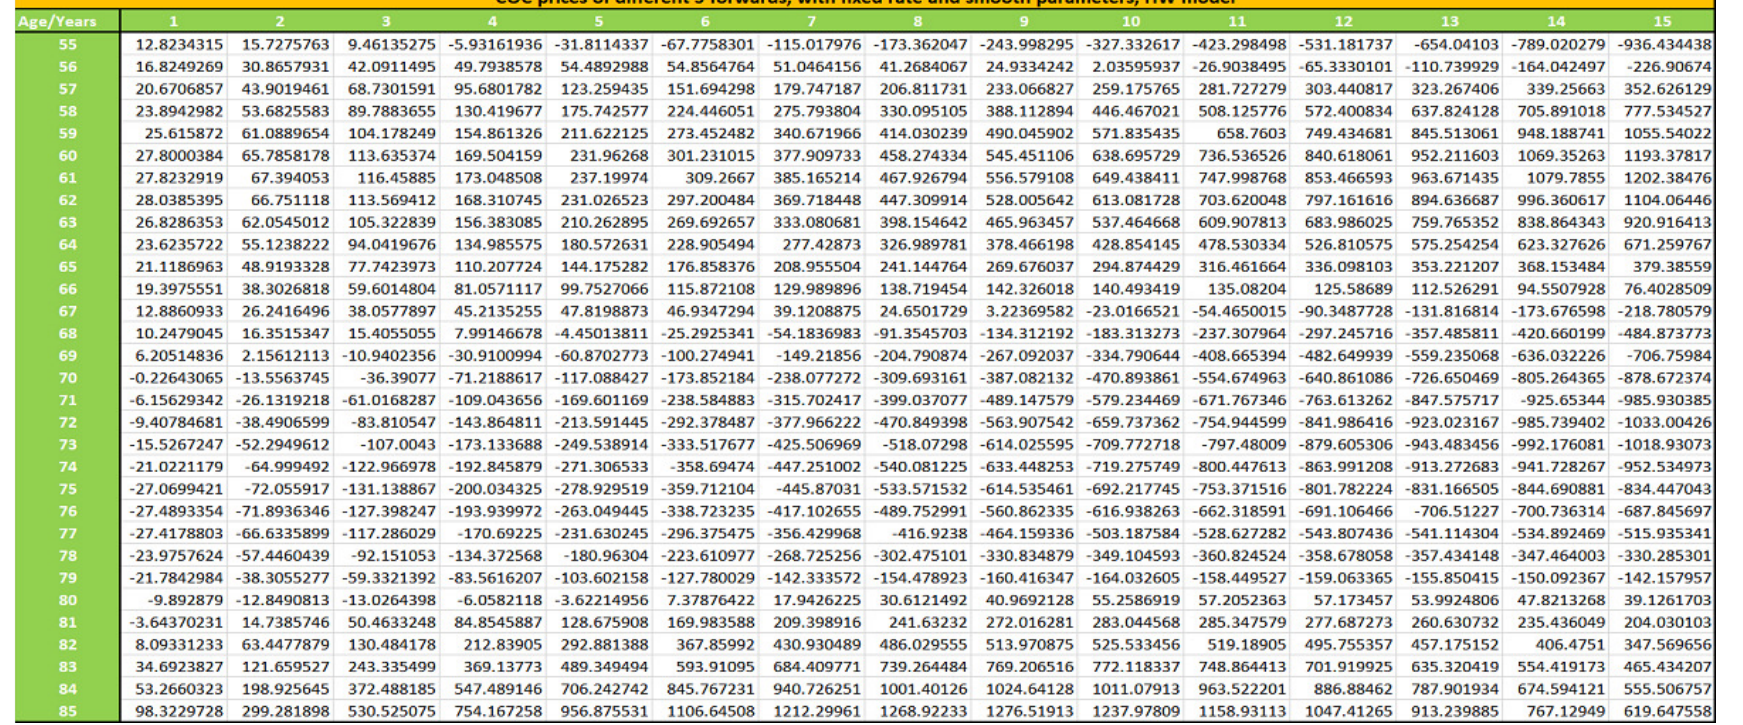
Figure A6. Prices of S-forward prices under the Cost of Capital approach with smooth parameters, HW